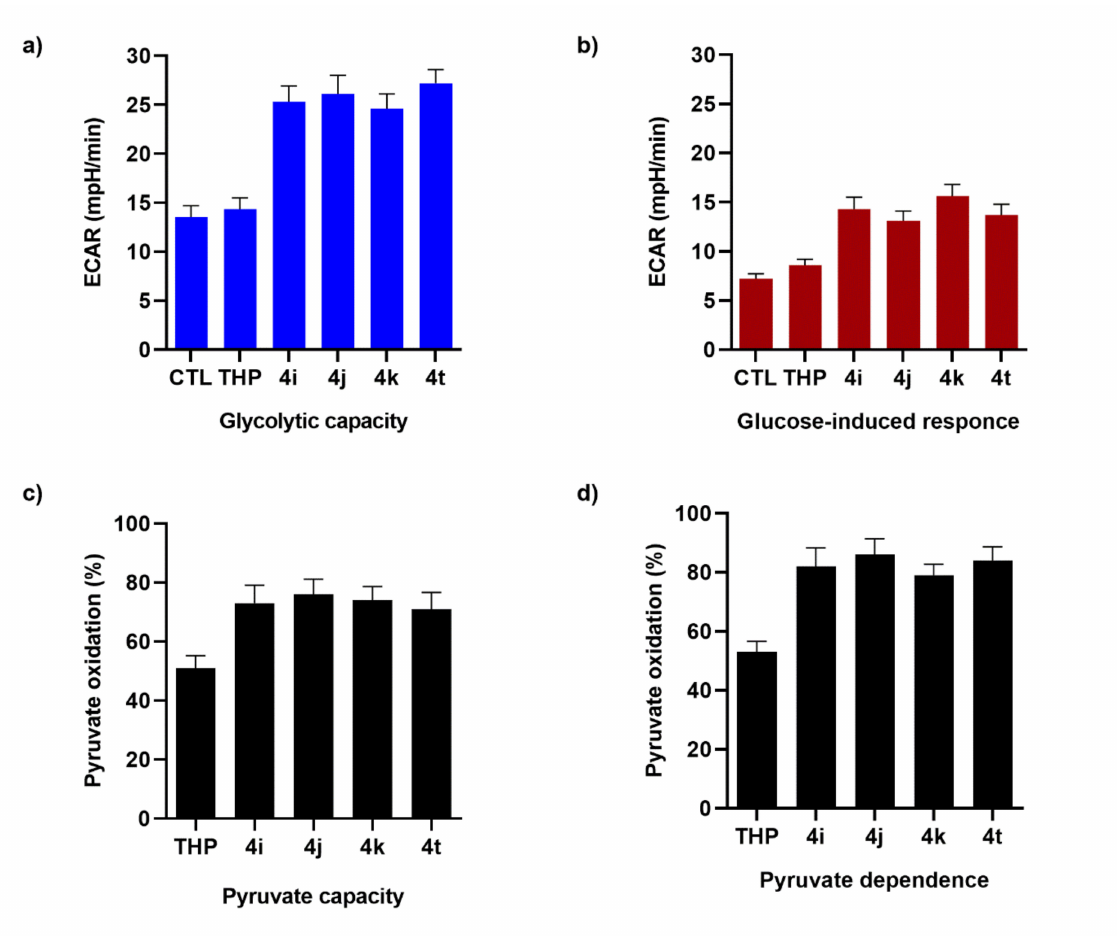
Figure 3. ( a , b ) STHdh Q111 / 111 treated with 50 µ M of THP or selected TCL; ( c , d ) Bioenergetics studies of STHdh Q111 / 111 cultured in the presence of pyruvate as a specific energetic substrate. The percent capacity to use pyruvate for respiration as well as the percent dependence on pyruvate was calculated as described in the Materials and Methods Section 4.9. Each experiment was independently repeated at least three times, in separate 24-well plates with each treatment in 4–12 replicate